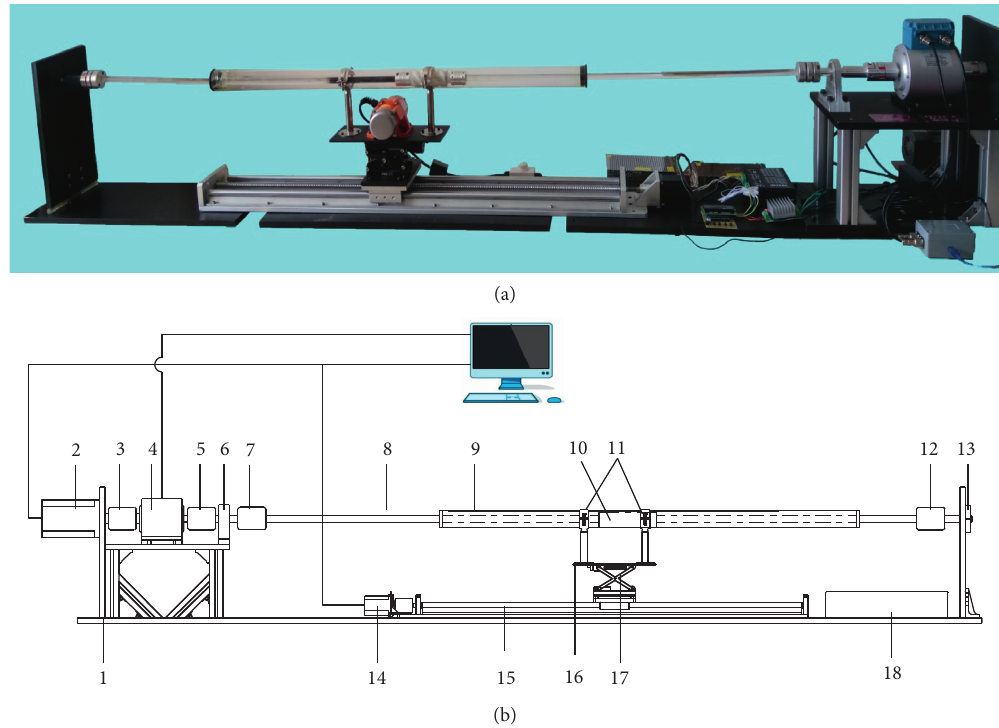
Figure 1: (a) Photograph of the experimental device used to test the performance of tools. (b) Schematic of the experimental device: (1) base, (2) main motor, (3) coupling A, (4) torque sensor, (5) coupling B, (6) bearing A and its support, (7) resilient coupling A, (8) inner rod (drill string), (9) outer cylinder (wellbore), (10) test tool, (11) support of outer cylinder, (12) resilient coupling B, (13) bearing B, (14) feed motor, (15) sliding table, (16) connection plate, (17) lifting table, (18) fluid container, and (19) computer.